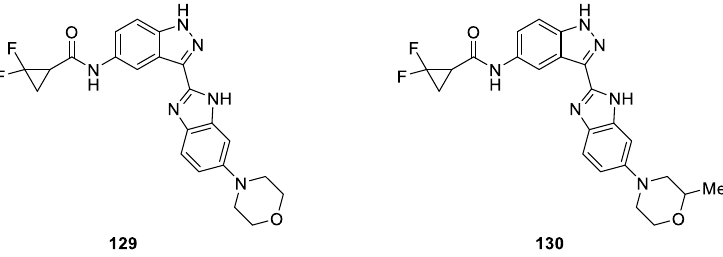
Figure 32. Chemical structures of 1 H -benzo[ d ]imidazol-2-yl)-1 H -indazol derivatives 129 and 130 .